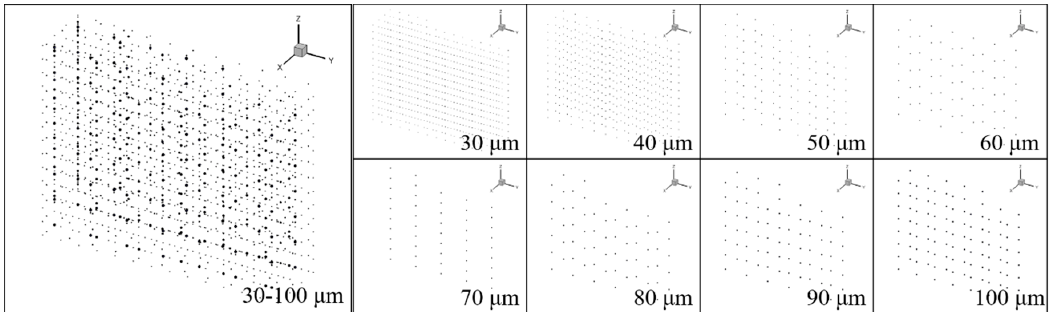
Figure 19. Distribution of initial nuclei of various sizes.